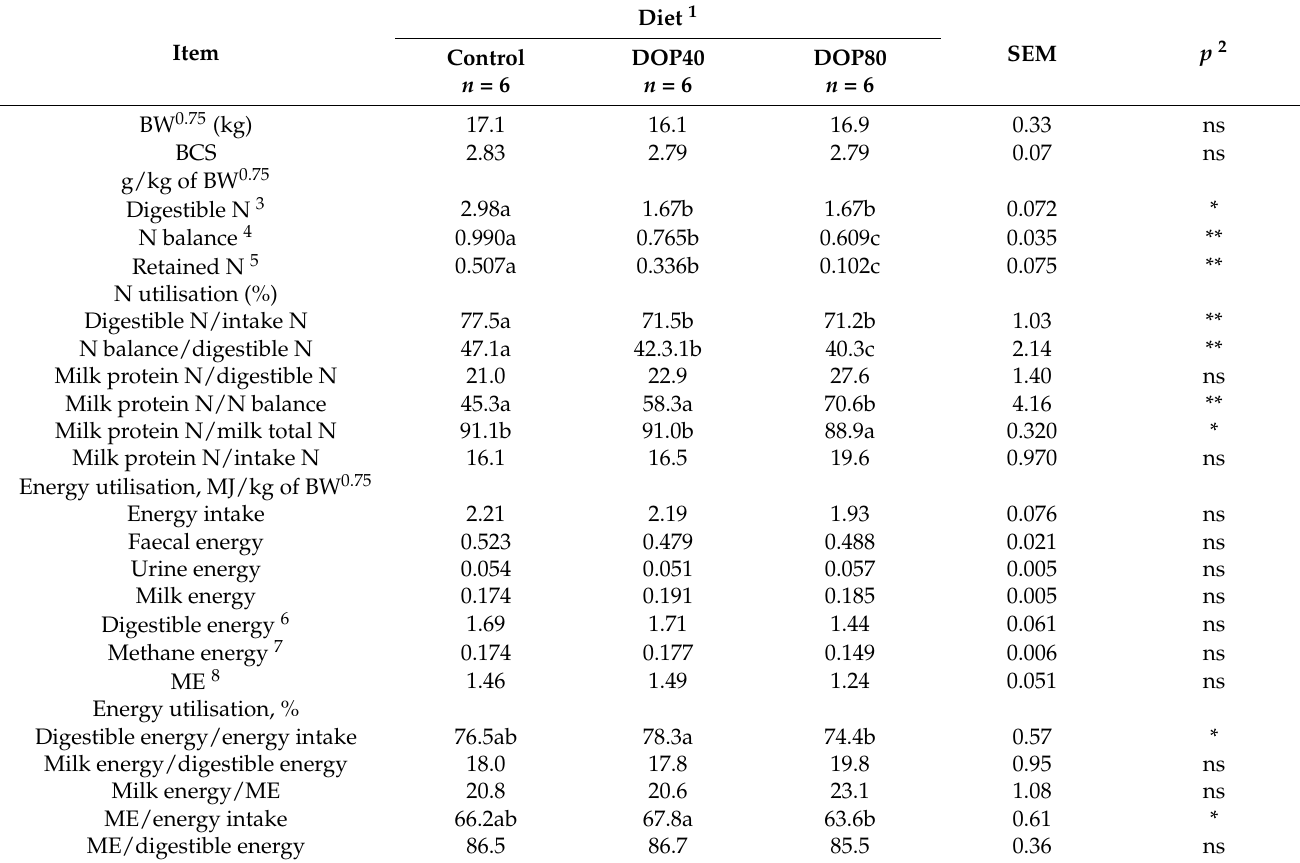
Table 5. Metabolic weight (BW 0.75 ), nitrogen and energy utilisation and feed efficiency in dairy goats fed the experimental diets.